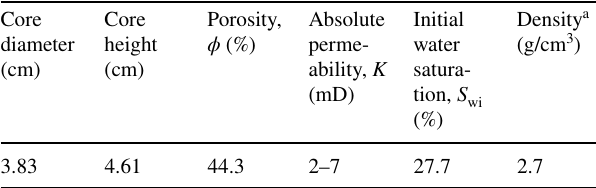
Table 1 Properties of core [Test 31 (Standnes and Austad 2000)]